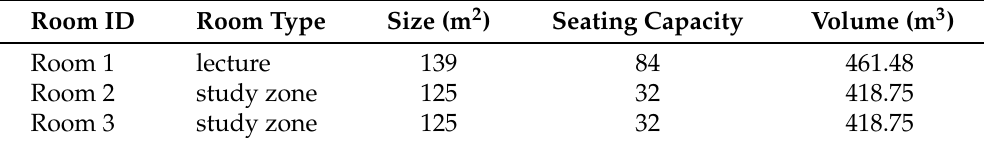
Table 2. Summary of target spaces.